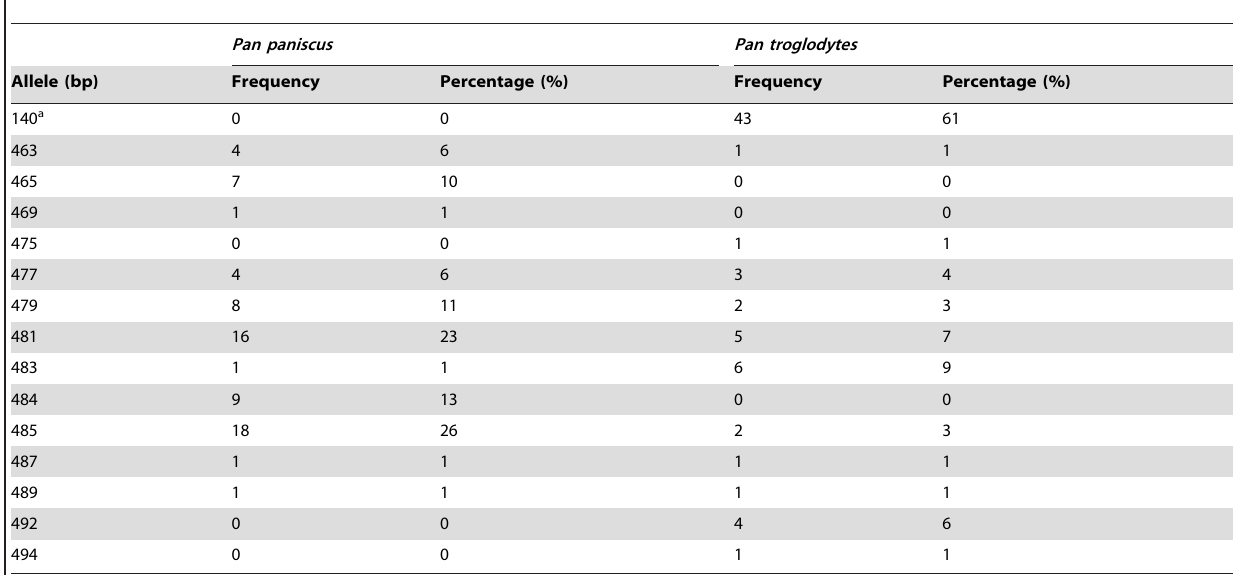
Table 2. Frequency and percentage of RS3 alleles found in an unrelated set of bonobos ( Pan paniscus ) (N =35) and chimpanzees ( Pan troglodytes ) (N